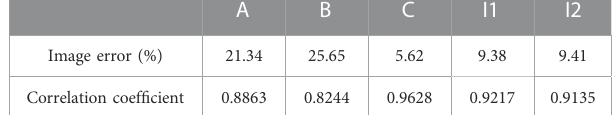
TABLE 3 Image error (%) and correlation coef fi cient for simulation results. TABLE 4 Average pixel value ratio of blood to the background for imaging results in Part Ⅱ